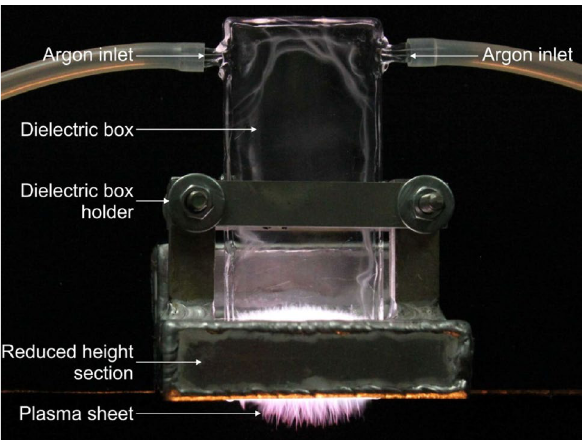
Figure 4. Photo of the microwave argon plasma sheet at argon flow rate of 20 NL/min and absorbed microwave power of 300